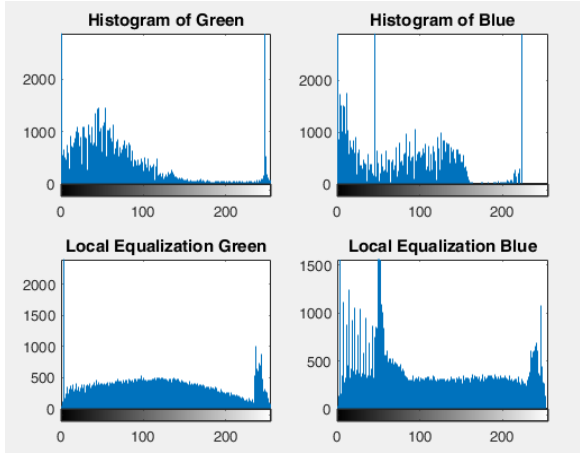
Figure 4. Before/after histogram equalizations of the left image